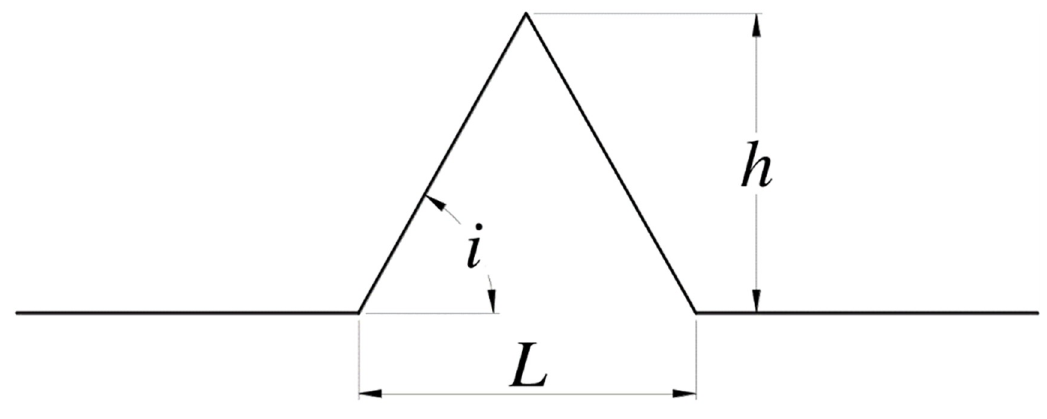
Fig 4. Generator of Koch’s